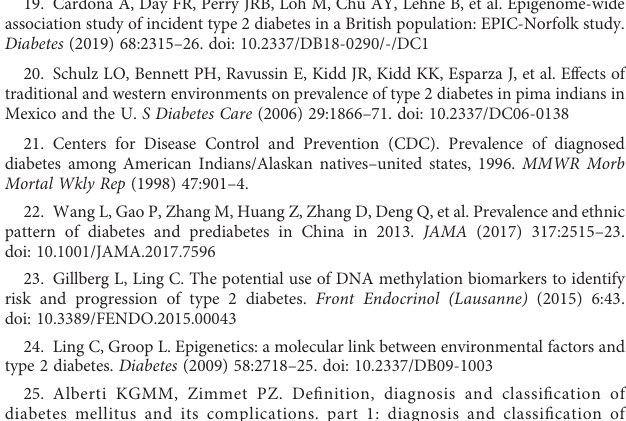
SUPPLEMENTARY FIGURE 2 Distribution of mC levels in mCG, mCH and mCHH. The fi gure showed the distribution of mC levels in 12 samples. The X axis showed the methylation level, and the Y axis showed the percentage of mC. Red, blue and green lines represent CG, CHG and CHH, respectively. H: Han, Z: Tibetan